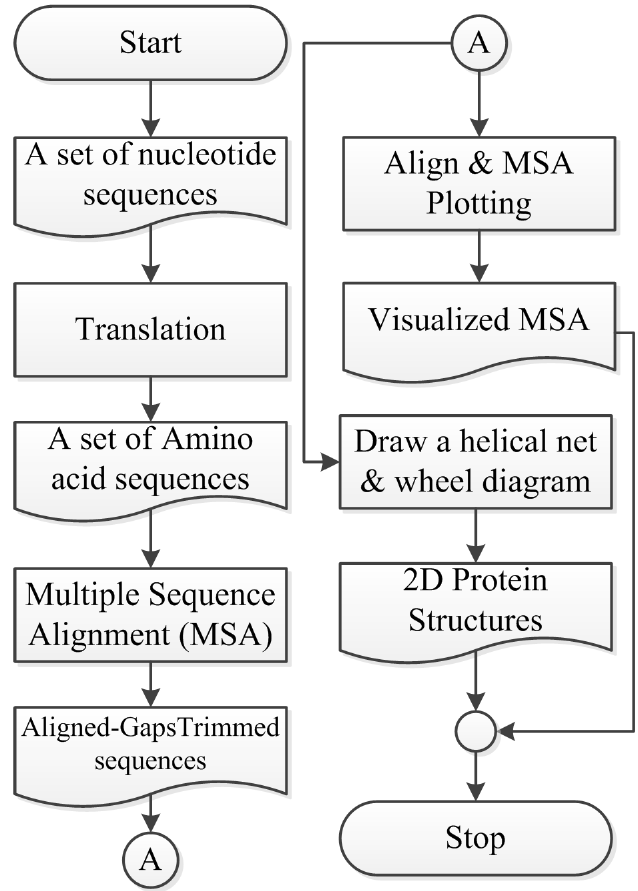
Figure 2: The proposed 2D protein structure analysis